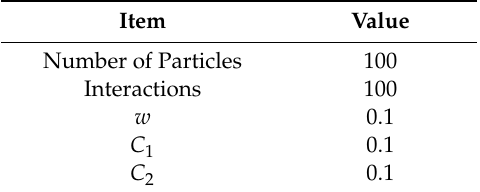
Table 1. Parameters of particle swam optimization